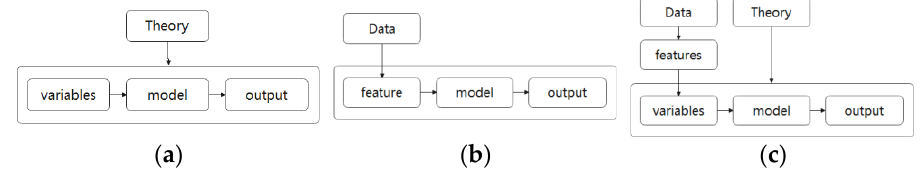
Figure 1. ( a ) Theory-driven, ( b ) data-driven [26], and ( c ) hybrid-driven paradigms.